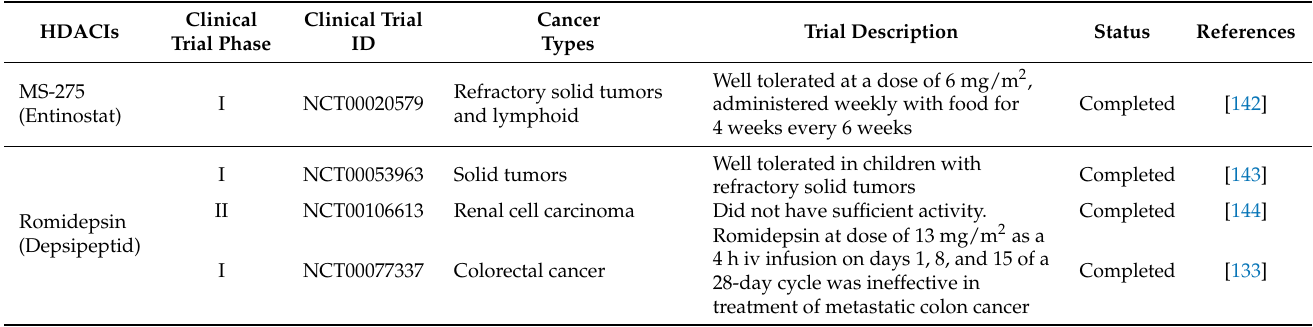
Table 2. HDAC inhibitors in clinical